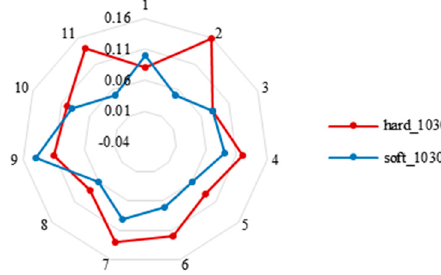
Figure 8. Comparison of tool wear [mm] over insert number after soft and hard machining tests.